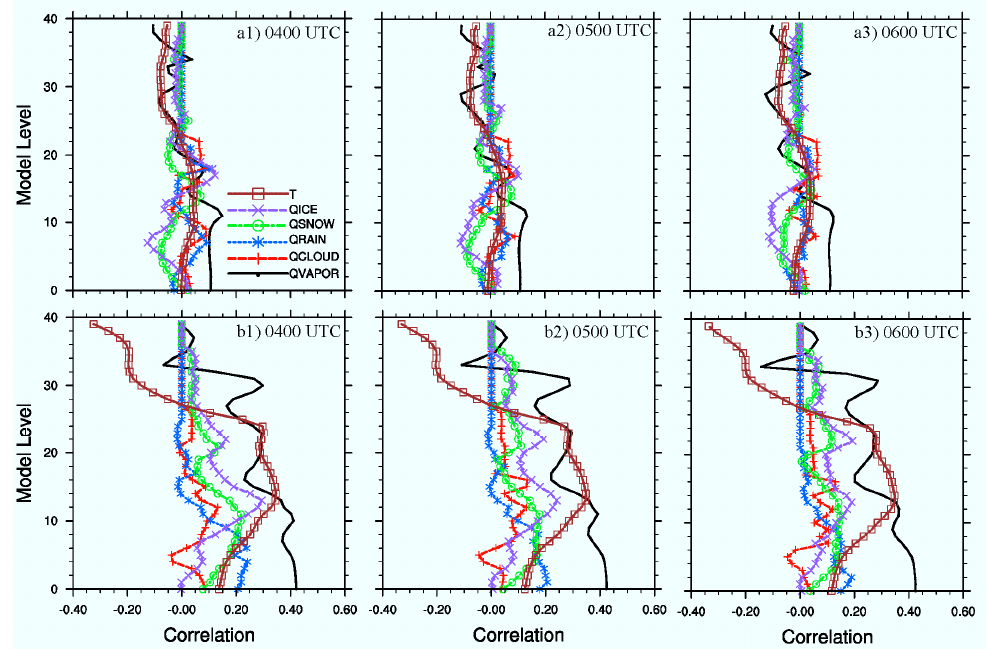
Figure 5. Correlations between remote sensing precipitation products and hydrometeorological variables or temperature from 04:00 UTC to 06:00 UTC on 21 June 2008: (a1–a3) from 04:00 to 06:00 for TRMM assimilation; (b1–b3) from 04:00 to 06:00 for FY assimilation.